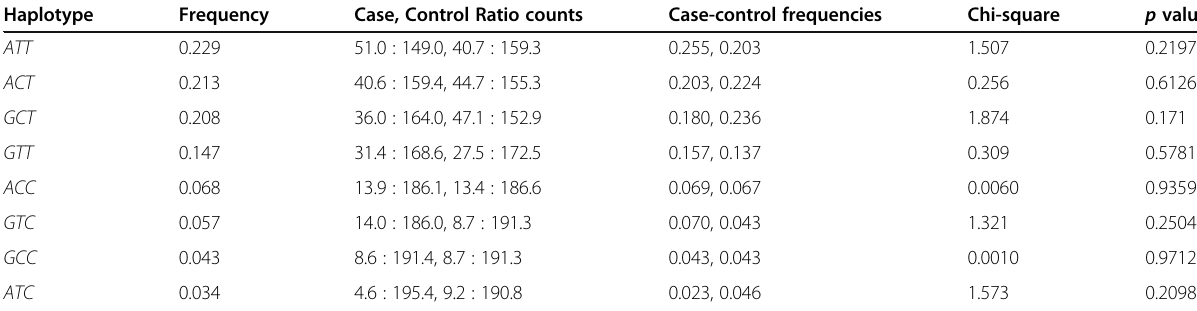
Table 9 The distribution of TLR4 haplotypes in patients and controls Haplotype